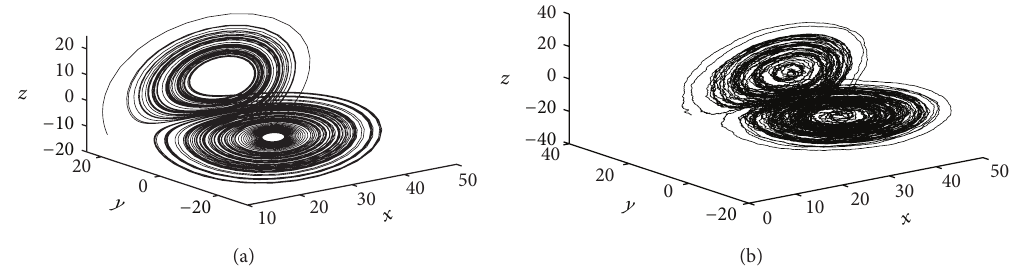
Figure 1: The attractor of the three states of the first